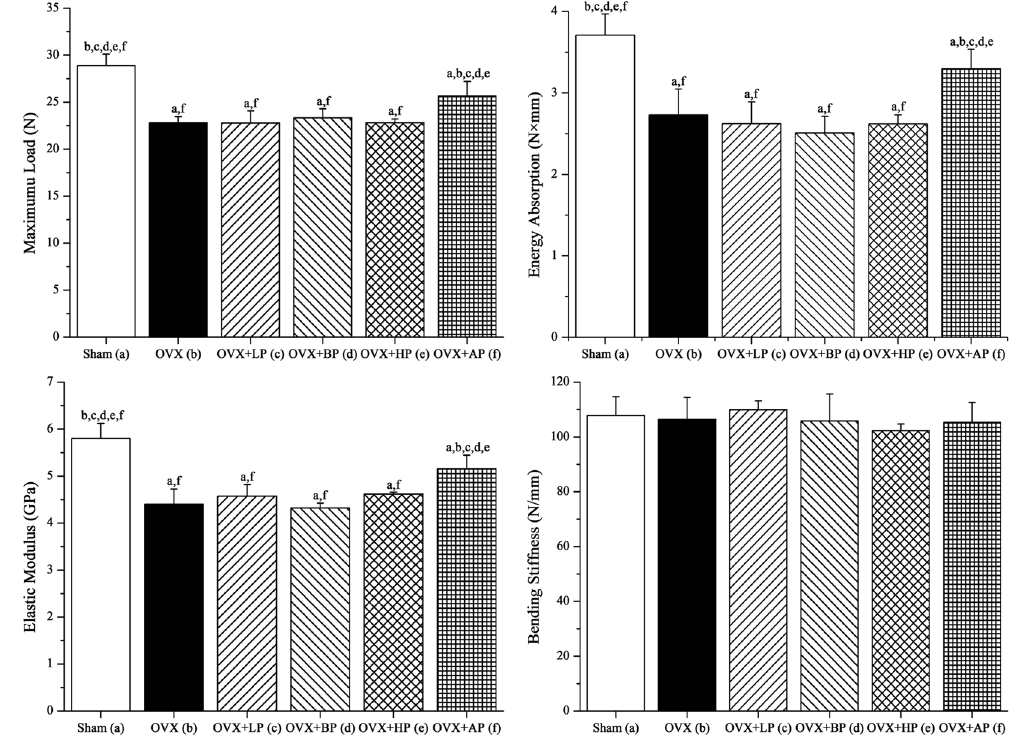
Figure 6. Effects of 8-week EMF exposure on femoral biomechanical structural properties in OVX mice via three-point bending test, including maximum load, energy absorption, elastic modulus and bending stiffness. Values represent mean ± SD of 8/group. Letters a-f indicate differences between respective groups at P < 0.05 or * P < 0.01 (a versus Sham; b versus OVX; c versus OVX + LP; d versus OVX + BP; e versus OVX + HP; f versus OVX +